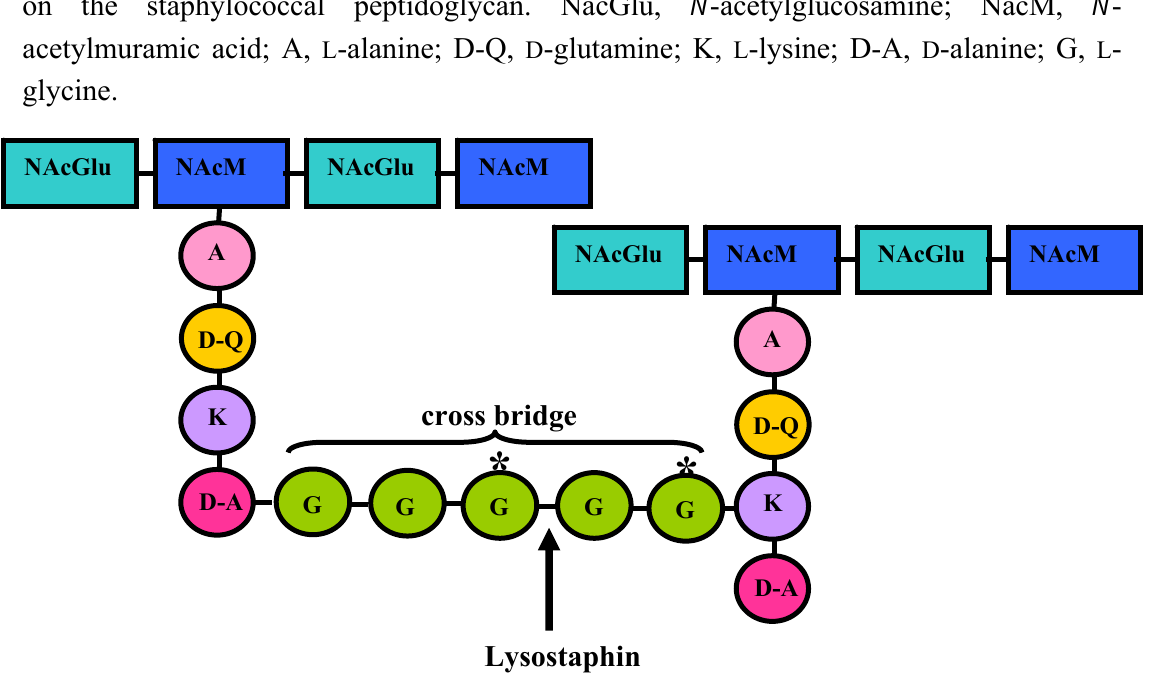
Figure 1. S. aureus peptidoglycan structure and site of primary hydrolysis of